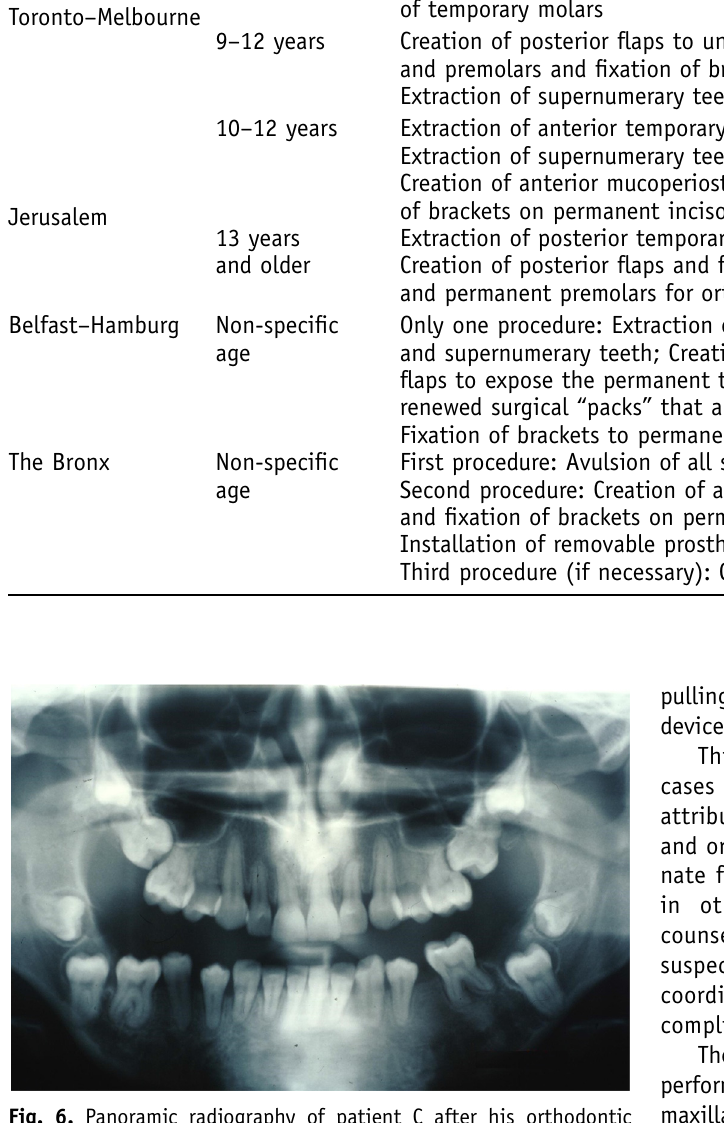
Fig. 6. Panoramic radiography of patient C after his orthodontic treatment (age: 23